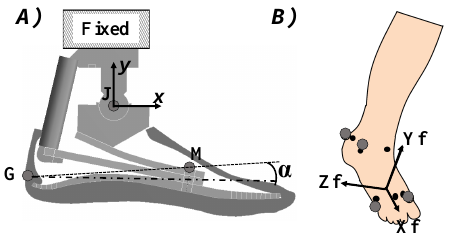
Figure 8. The foot rotation α is calculated as the variation of the angle between the shank axis and the GM line. The G and M markers taken into account in ( A ) are referred to the reflective markers (grey circles in ( B )) considered by Leardini et al.